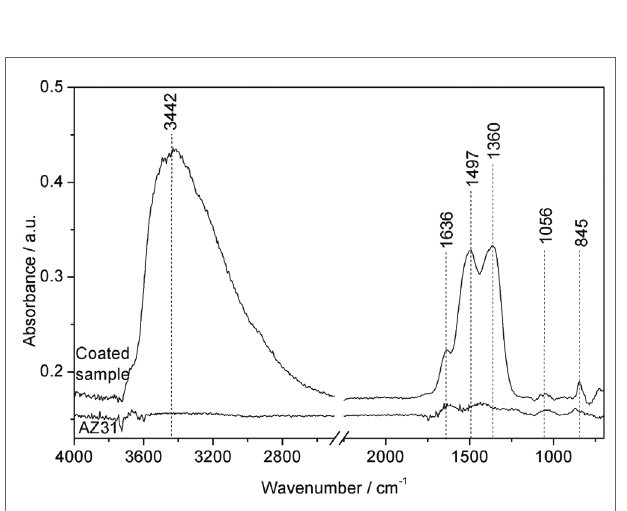
FigUre 4 | irras data of aZ31 and the ce oxide-coated sample .